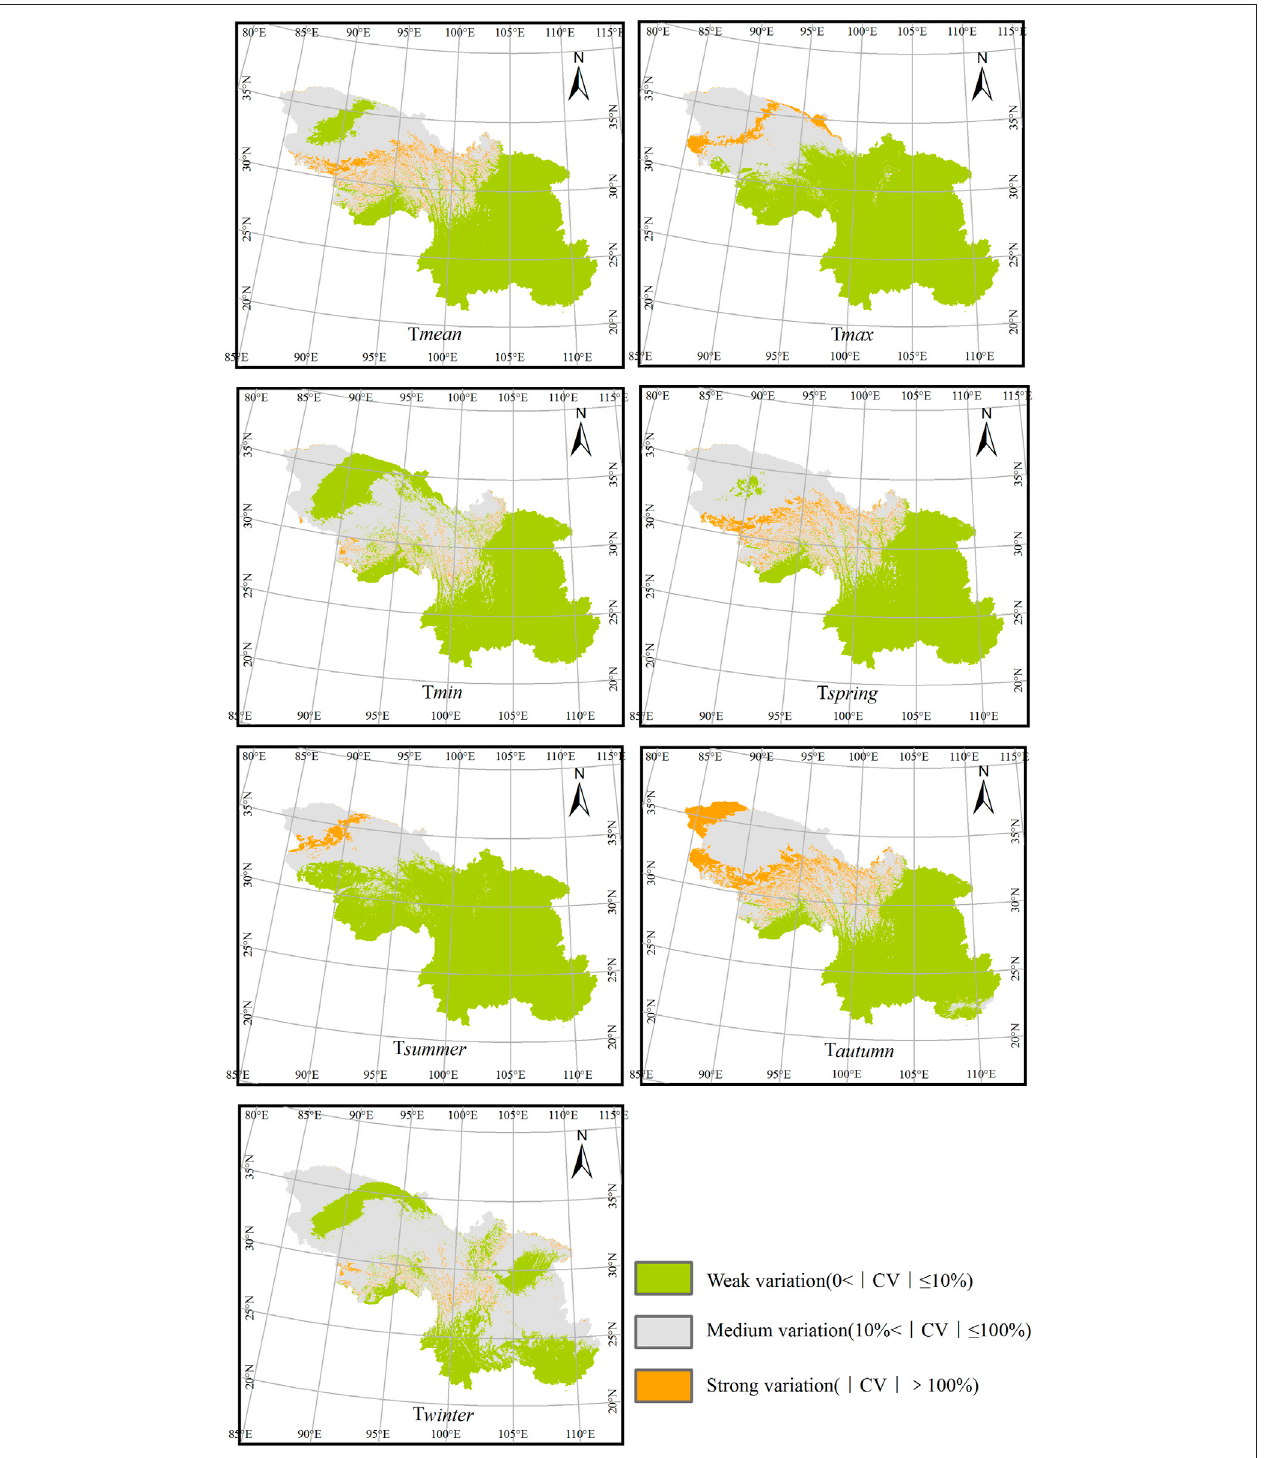
FIGURE 8 | Coef fi cient of variation (CV) index for NSAT over Southwest China for the period 1969 – 2018. Panels (A – G) correspond to the mean annual, mean annual maximum, mean annual minimum, mean spring, mean summer, mean autumn, and mean winter NSATs, respectively.